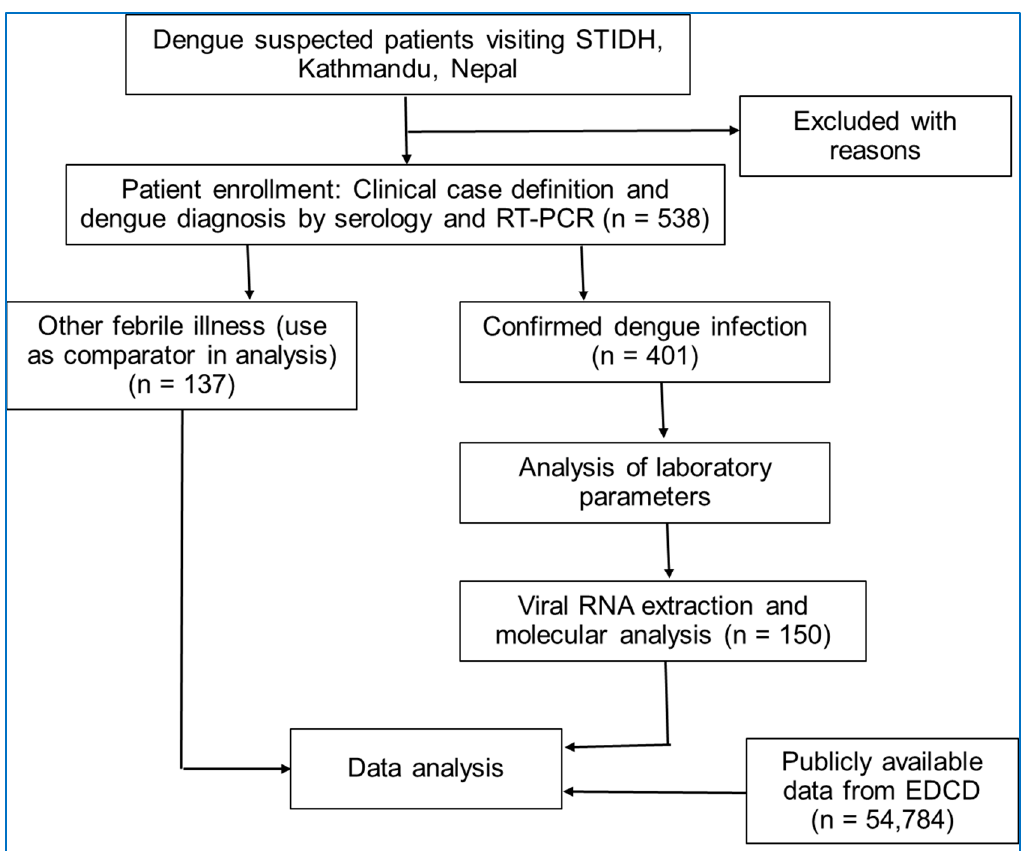
Figure 2. Flow diagram of the study showing patient enrollment, investigation and analysis ap-